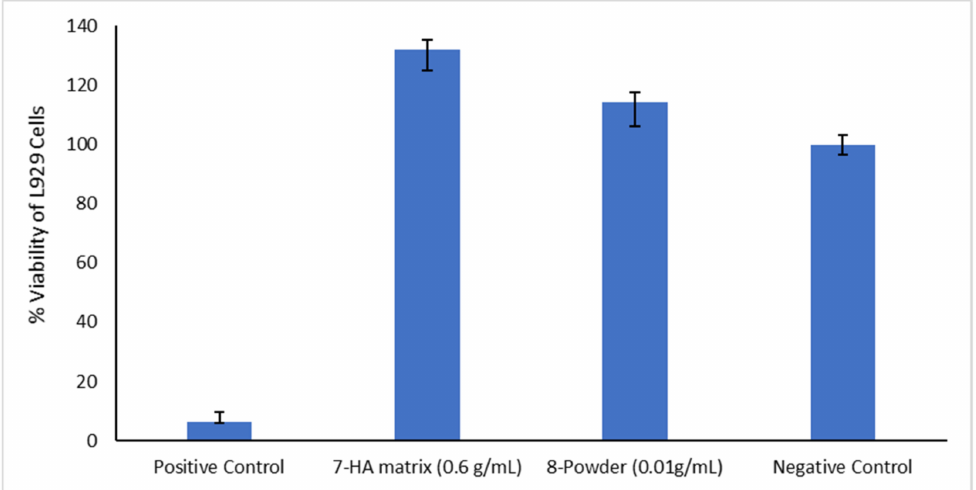
Figure 6. Results of the MTT